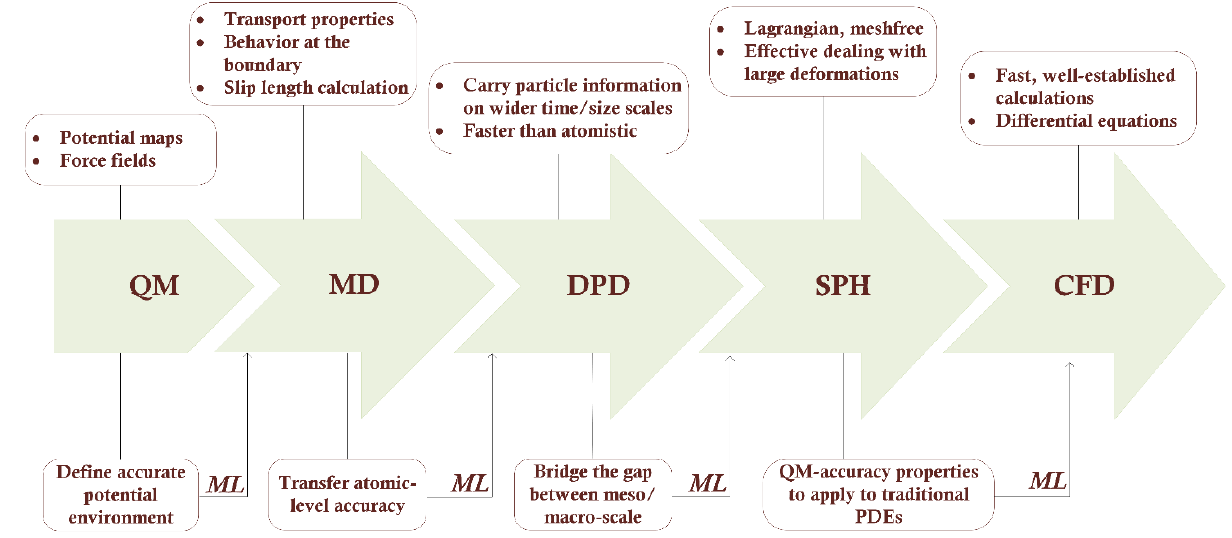
Figure 1. Multiscale modeling facilitated by ML.